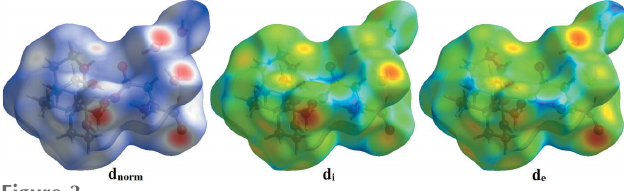
Figure 3 The Hirshfeld surfaces of the title compound mapped over d norm , d i and d e .